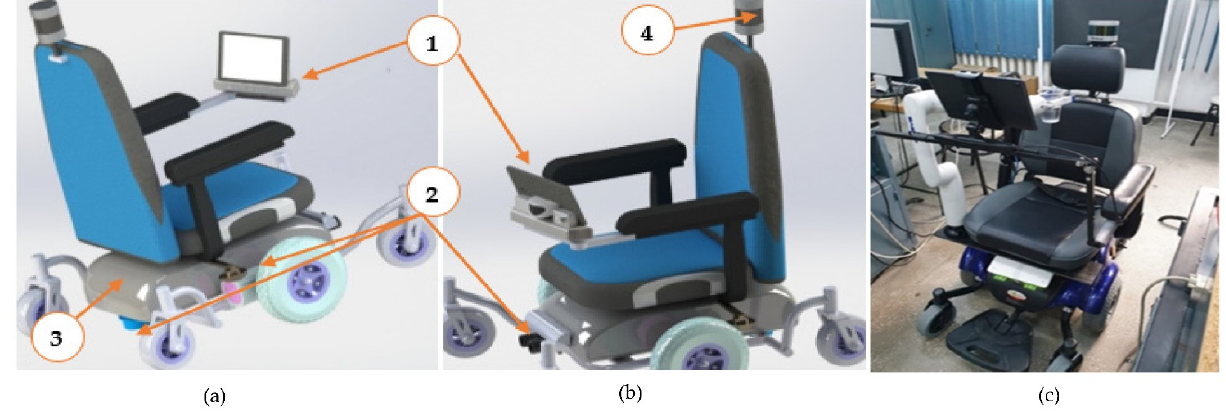
Figure 1. Intelligent wheelchair ( a ) rear-view, ( b ) front-view; 1—sensorial system (eye gaze, head movements, facial expressions); 2—proximity sensorial system; 3—energetic system; 4—3D mapping system; ( c ) the current implementation of the sensory system on the autonomous wheelchair.